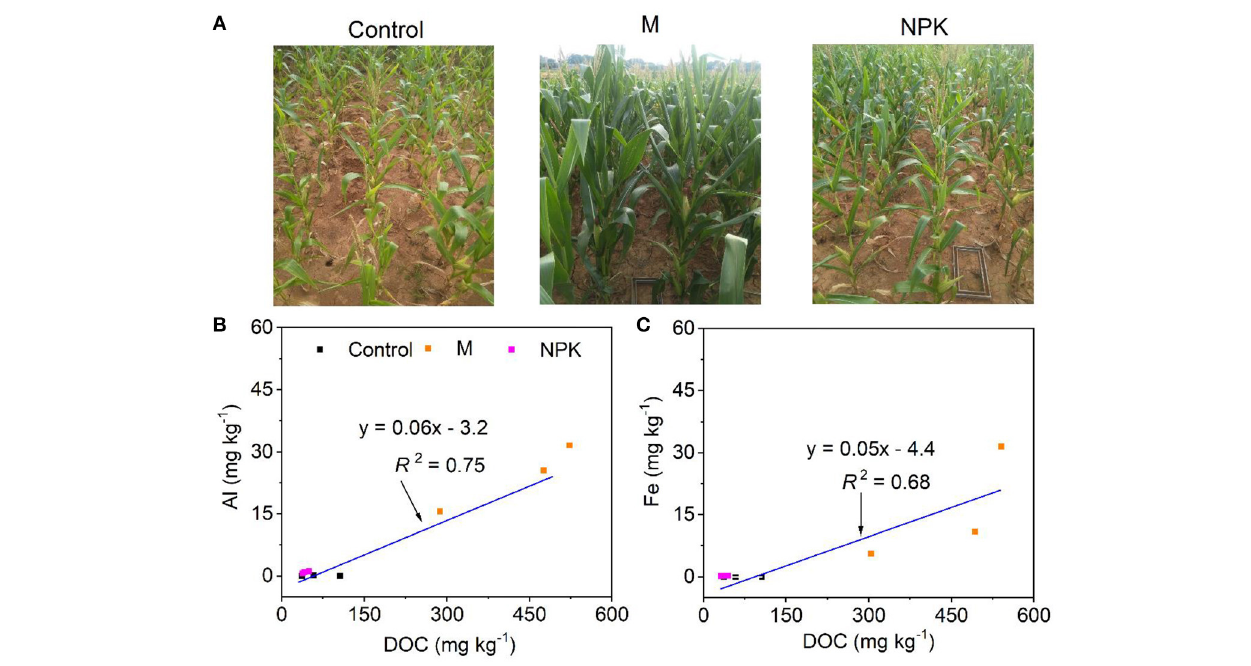
FIGURE 1 | Photos of the field study (A) and associations between mineral elements and DOC (B,C) at the Jiangxi Institute of Red Soils, Jinxian, China. Corn ( Zea mays L.) was planted under different fertilization treatments. Control, no fertilization; M, farmyard manure fertilization; NPK, chemical